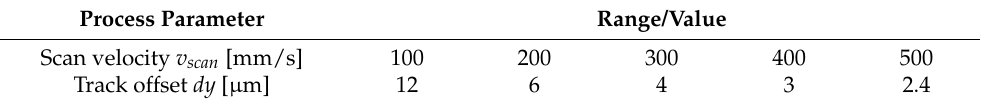
Table 3. Tabular overview of process parameters and range of investigation.